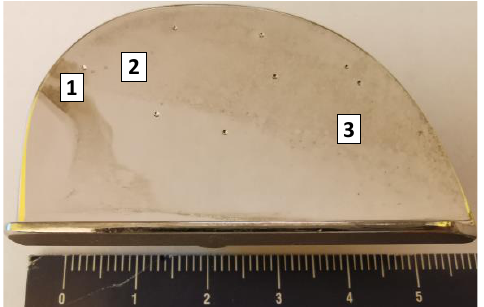
Figure 9. Indication of analyzed zone. (1- damage-free zone, 2- tribological wear zone, 3- zone surface with visible branched cracks).